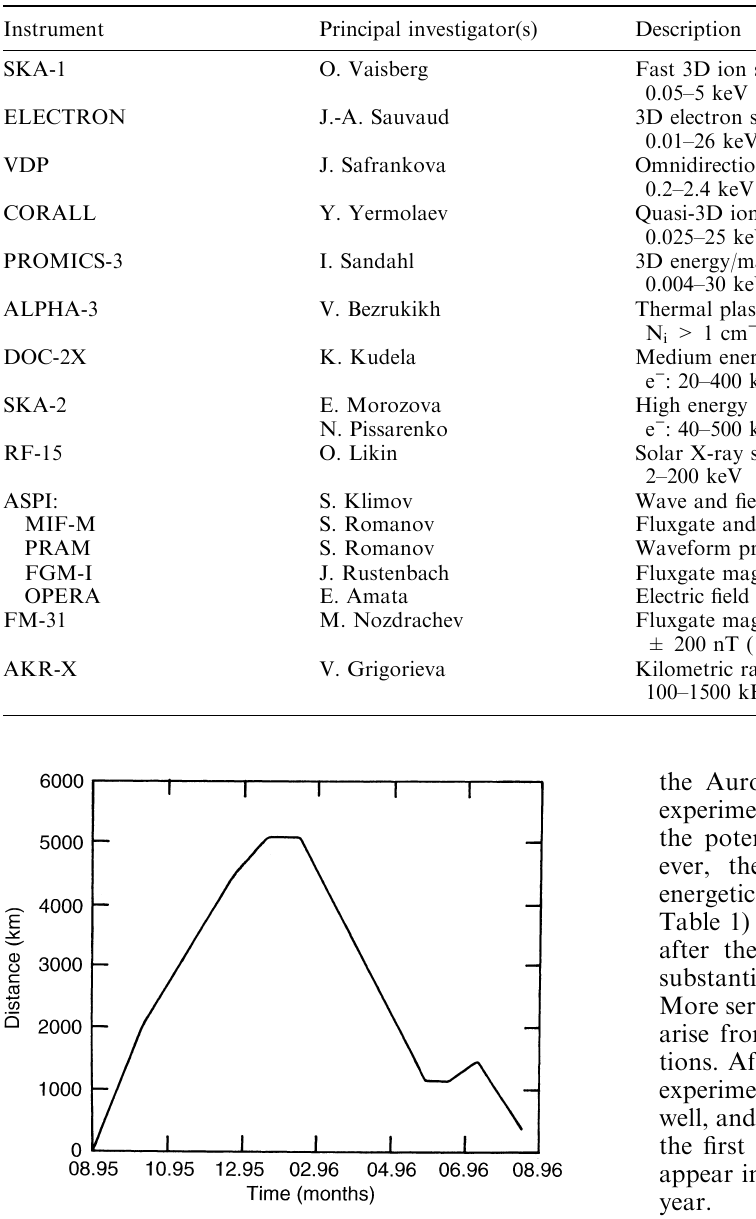
Fig. 4. Satellite-to-sub-satellite separation when located at 100,000 km from the Earth, as a function of